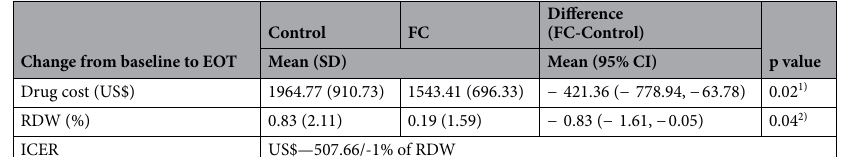
Change from baseline to